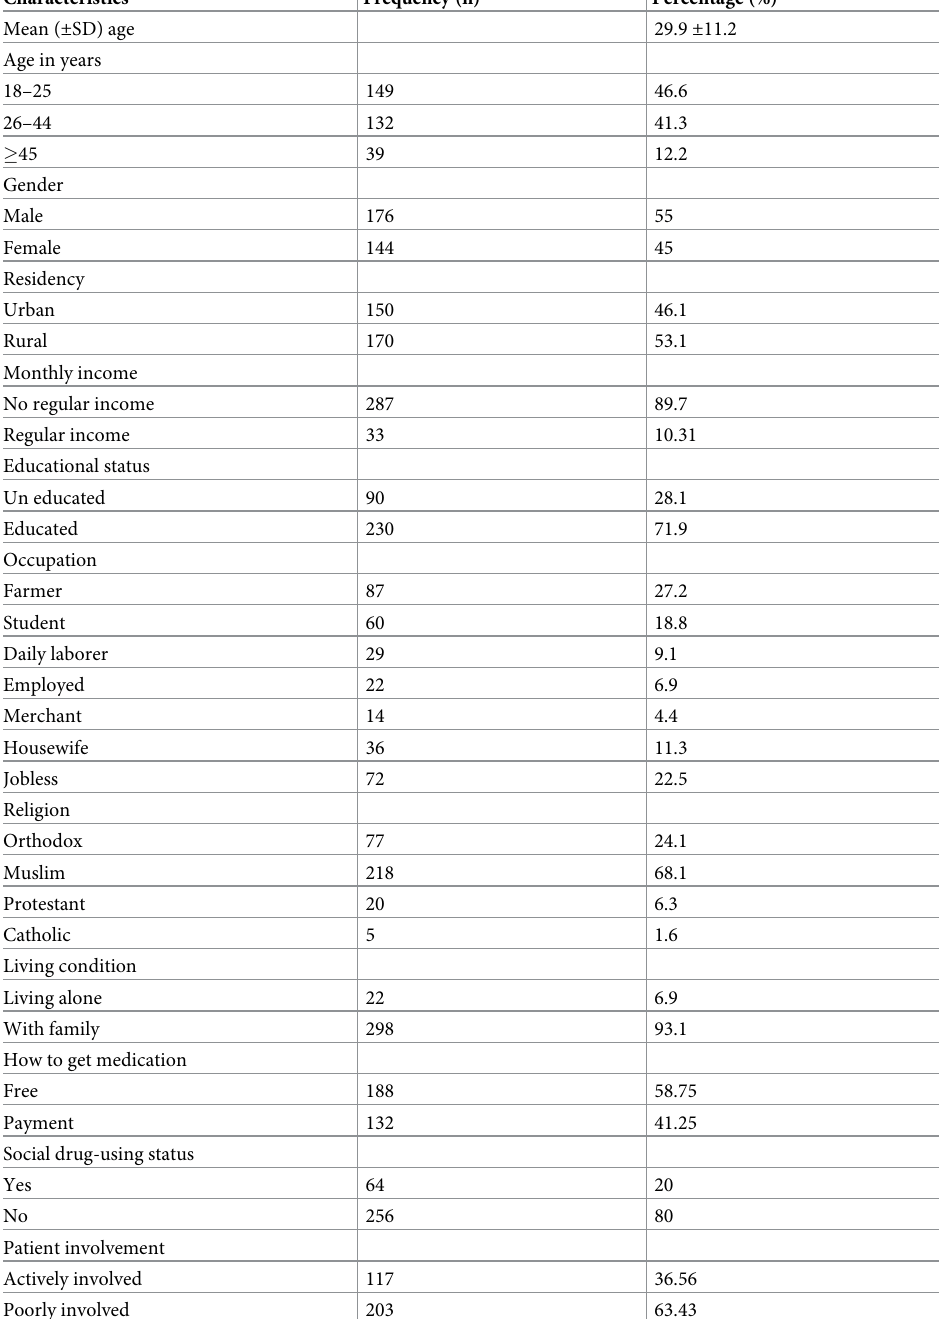
Table 1. Socio-demographic and behavioral related characteristics of epileptic patients attending the ambulatory clinic of JMC, 2021.